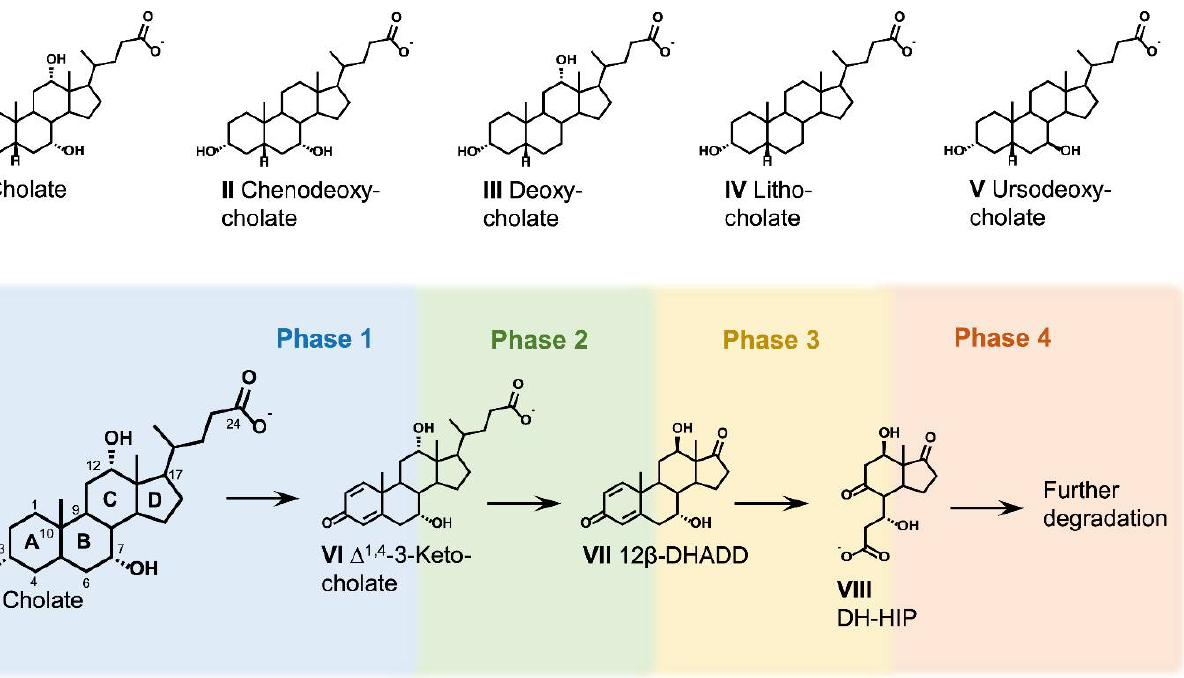
Figure 2. General aspects of bile acid degradation. ( A ) Structures of the most common bile acids in humans. ( B ) General scheme of bile acid degradation by bacteria. For bile acids, the respective deprotonated bile salts are depicted. Abbreviations: 12 β -DHADD, 7 α ,12 β -Dihydroxy-androsta-1,4-diene-3,17-dione; DH-DHIP, 3′,7-Dihydroxy-H-methyl-hexahydro- indanone-propanoate.